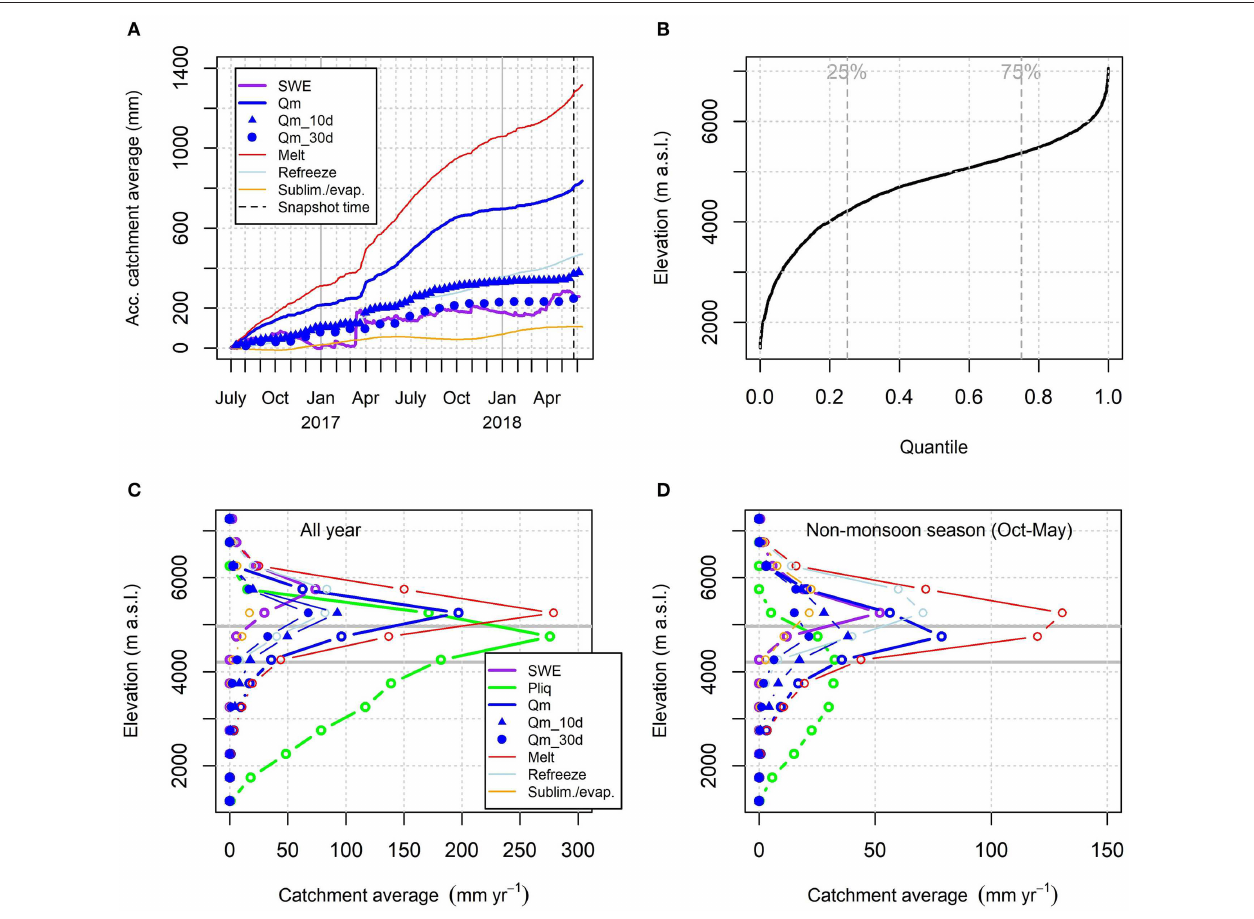
FIGURE 7 | (A) Simulated accumulated snow-related water sources, stores and losses [mm, mean over the Langtang catchment] from July 2016 to June 2018. (B) The cumulative area-fraction vs. elevation distribution in the Langtang catchment. (C,D) As in (A) but now based on a “snapshot” of the accumulated values at the end of May 2018 and shown in units [mm yr − 1 ] (catchment average) for each 500m elevation band for the all-year (left) and drier non-monsoon periods (October-May; right panel; note the different scale on x-axis). SWE is the snow store, and P liq and Q m the rainfall and snow melt water sources, respectively. Q m_ 10 d and Q m_ 30 d are the snow melt water sources derived from > 10 and > 30 days old snow, respectively. The thin lines (melt, refreeze, sublim./evap.) denote the surface snow melting, refreezing of liquid water within the snow pack, and sublimation/evaporation from the snow pack, respectively. The 4,200–4,962m a.s.l. elevation interval monitored by the four stations is indicated by the two horizontal gray lines in (C,D)